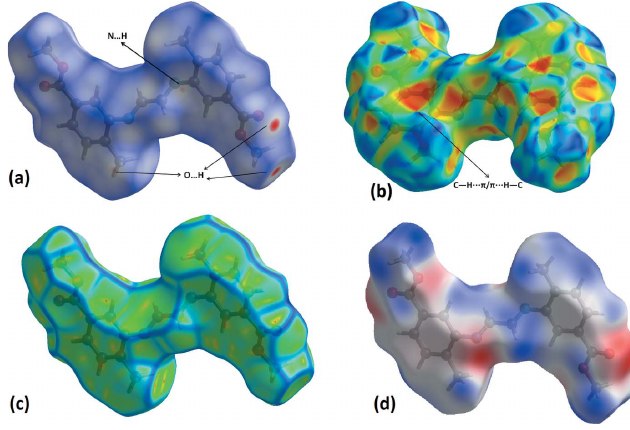
Figure 3 The Hirshfeld surface of the title compound mapped over ( a ) d norm , ( b ) shape-index, ( c ) curvedness and ( d ) electrostatic potential.